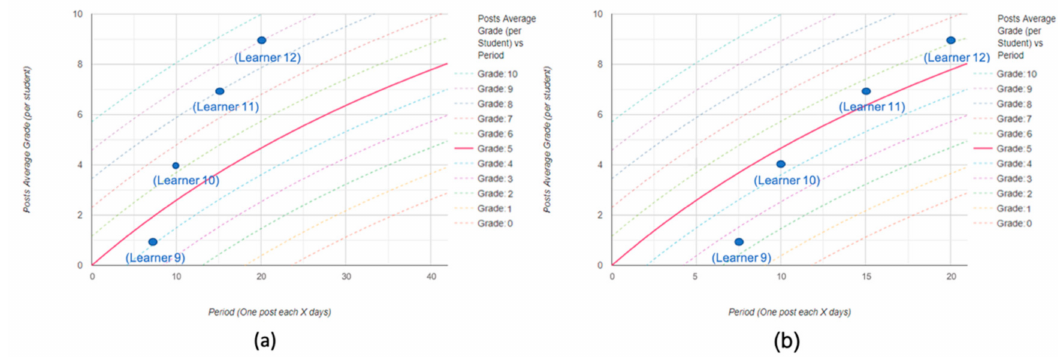
Figure 5. Chart representing f ( x ) plus some other curves calculated through the Euclidean distance to f ( x ) in the range from 0 to 10 points for two values of C: ( a ) low value of C ( b ) high value of C. Scenario ( b ) requires a higher number of posts by the to get the same score. It is important to note that the scale changes on the